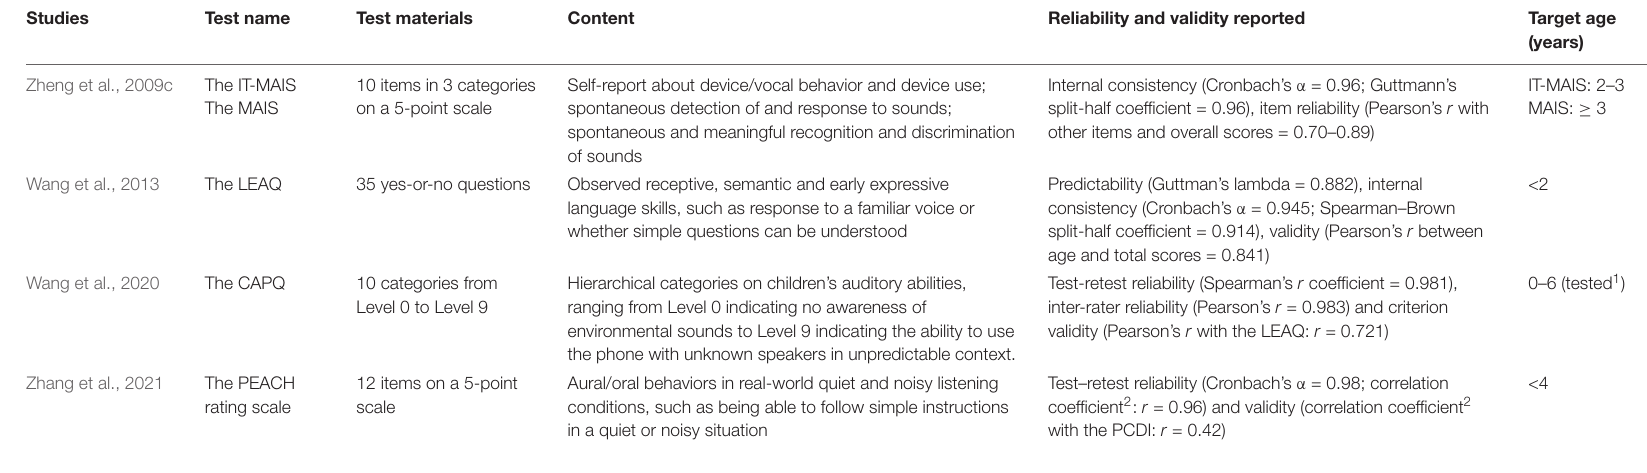
TABLE 1 | Parental